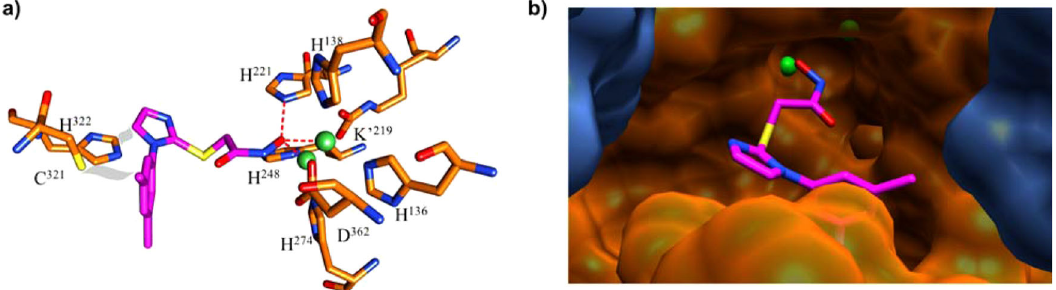
Fig. 6 SHA bound at the active site of H. pylori urease. a Interactions of SHA, with dashed red lines showing interactions of the hydroxyl moiety of the hydroxamic acid: a hydrogen bond from His221 N ε 2 and coordination of the two Ni 2 + ions. In gray van der Waals interactions of the SHA imidazole and phenyl groups with the tip of the fl ap region. b Binding pose of SHA with the surface of catalytic subunit UreB in orange and the tip of the fl ap region in the foreground, while the surface of neighboring UreB ’ is shown in blue. The two Ni 2 + ions are shown in green. Note the space to the left of the SHA imidazole toward UreB ’ that could be exploited with modi fi ed